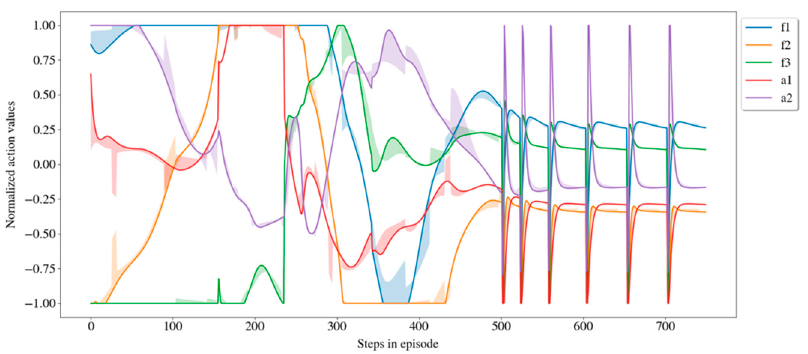
Figure 9. Visualization showing changing values of azimuth thruster forces and angles of a simulated ASV docking. This is meant for the developer (adapted from [42], image used with permission).